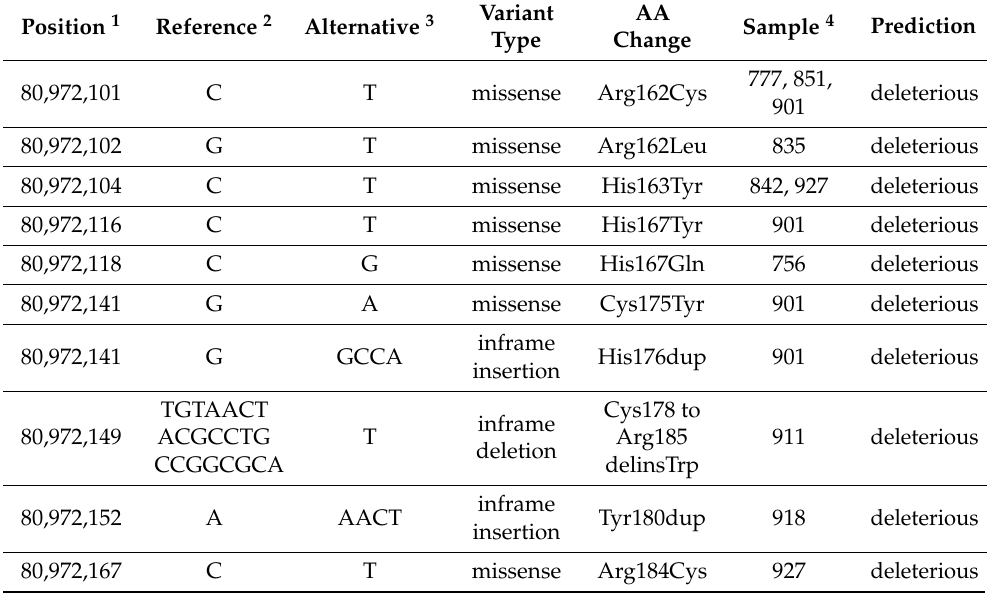
Table 1. Somatic mutations in the DNA-binding domain of IKZF1